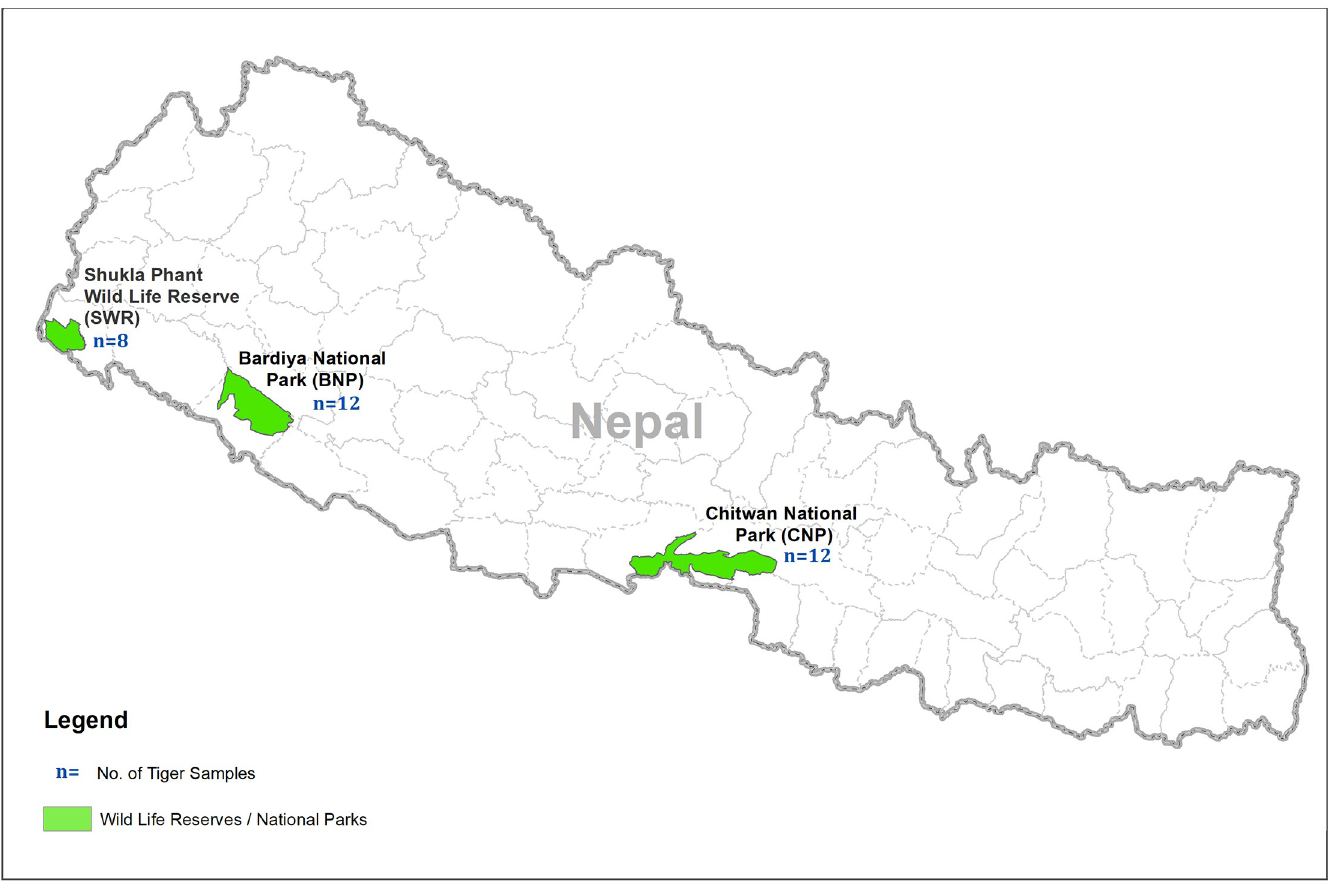
Fig 1. Scat sample collection sites for tiger baseline genetic database under Nepal Tiger Genome Project (NTGP, 2011–2013). We identified 120 individual tigers using 8 microsatellite markers from TAL (SWR = 19, BNP = 32, CNP = 69). A total of 70 tiger scat samples from 32 identified individual tigers (CNP = 12; BNP = 12; SWR = 8) were randomly selected for gut microbiota